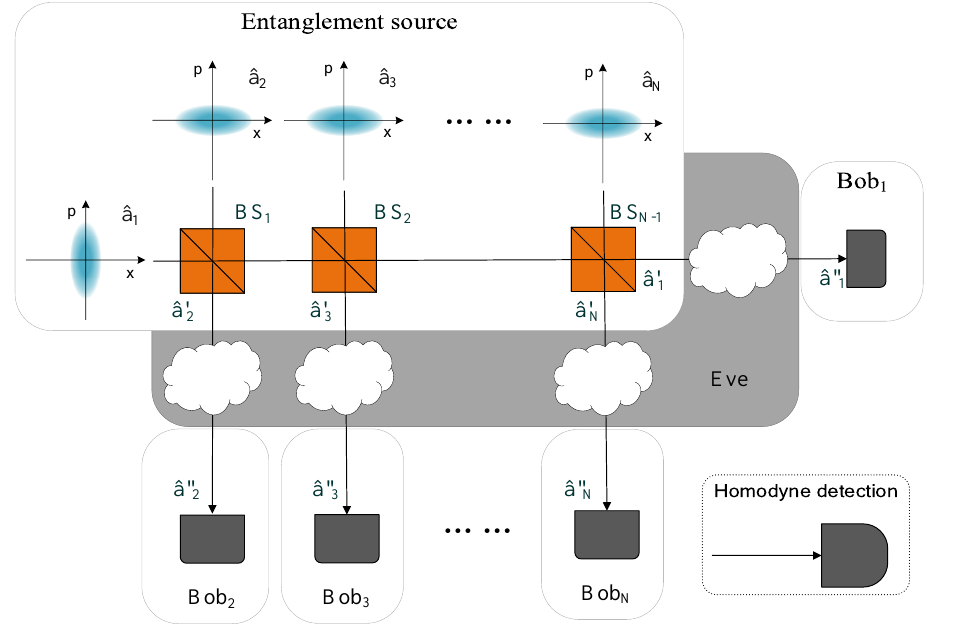
Figure 1. Schematic of the multipartite CV quantum conferencing scheme with entanglement in the middle. The source prepares CV squeezed states ˆa 1, ··· , N , and combines them by beam splitters BS 1, ··· , N . The output entangled modes ˆa (cid:48) are distributed to legitimate users Bob 1, ··· , N through 1, ··· , N noisy quantum links, which are controlled by the eavesdropper Eve. The users receive the modes ˆa (cid:48) and perform homodyne detection on them to distill mutual 1, ··· , N